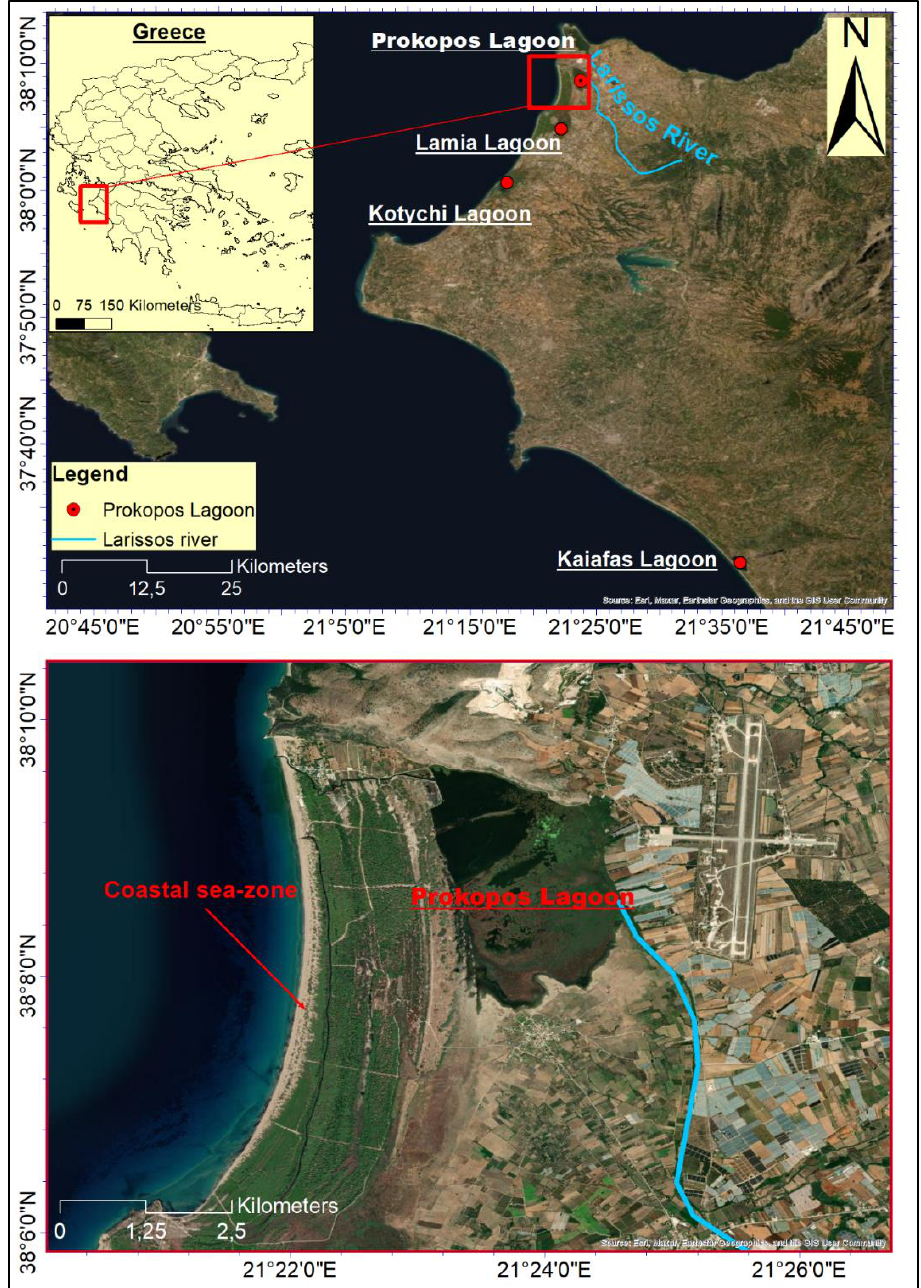
Figure 2. The major coastal lagoonal ecosystems of western Peloponnese and the location of the study area (Prokopos Lagoon).